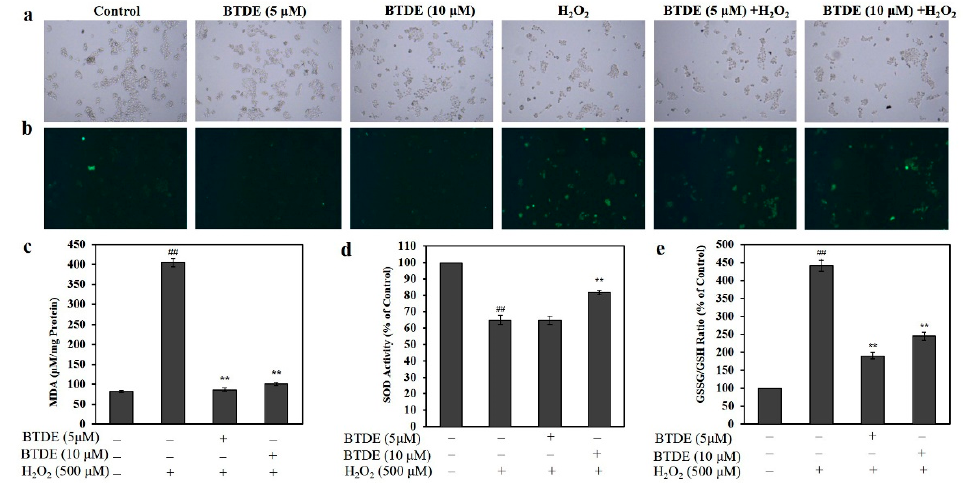
Figure 4. BTDE reduces ROS, MDA levels, and GSSG/GSH ratio, and it increases SOD activity in HaCaT cells. HaCaT cells were pretreated with BTDE (5 and 10 µ M) for 24 h and then were exposed to H 2 O 2 (500 μ M) for 1 h. Cells were incubated with DCFH-DA (10 μ M) for 20 min, and the cell morphology ( a ) and ROS level ( b ) were observed with fluorescence microscopy. The levels of MDA ( c ), SOD ( d ), and the ratio of GSSG/GSH ( e ) were measured using the indicated kit. Data are presented as the mean ± SD of three independent experiments. ## p < 0.01, versus control group, ** p < 0.01, versus H 2 O 2 -treated group.